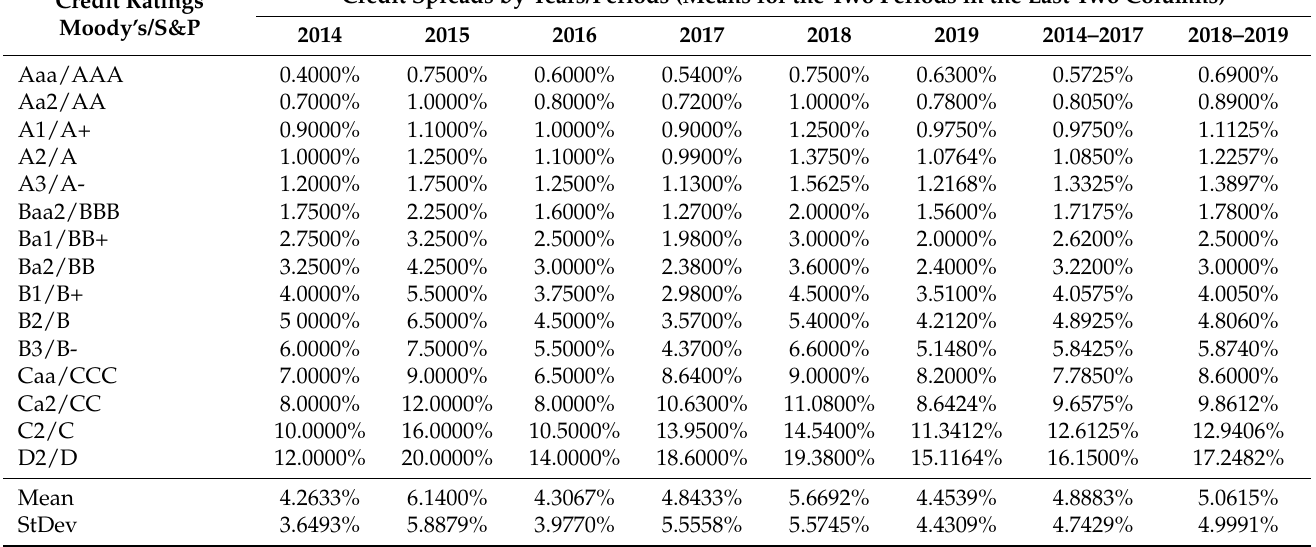
Table 5 report values covering the years from 2014 through 2019 for eleven